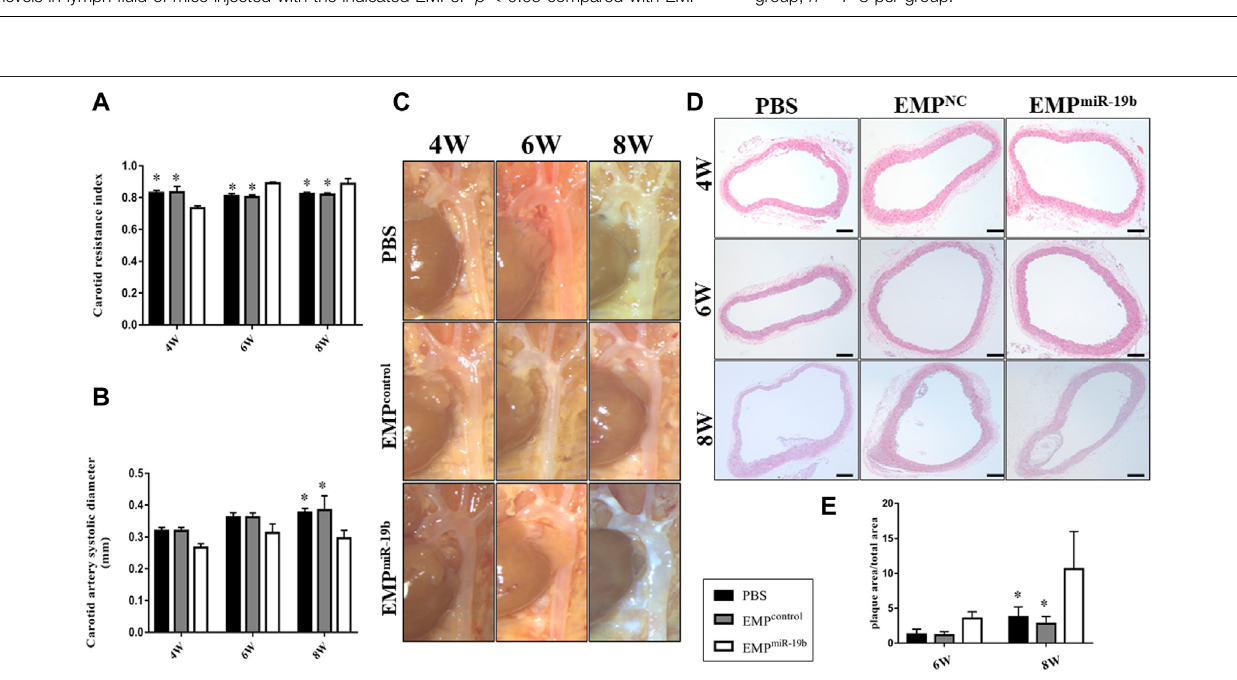
FIGURE 3 | EMP miR-19b promotes atherosclerotic plaque formation in ApoE − / − mice. (A) Carotid ultrasound was used to assess arterial fl ow velocity (V) of carotid artery. The peak systolic velocity (PSV) and end-diastolic velocity (EDV) were measured and used to calculated the resistive index (RI) = (PSV – EDV)/PSV, as a fl ow parameterre fl ectingvascularresistanceandvascularcompliance. (B) Aorticdiameterinsystolicstageasameasureofarterysize. (C) Grosspathologicalspecimenfrom high-fat diet-fed ApoE -/- mice intravenously injected with PBS, EMP control or EMP miR-19b for 4, 6, or 8 weeks. Representative images are presented. (D) Representative images of H&E staining of aortic sections from high-fat diet-fed ApoE − / − mice intravenously injected with PBS, EMP control , or EMP miR-19b for 4, 6, or 8 weeks. (E) Quantitative morphometric analysis of lesion area in (D) . * p < 0.05 compared with EMP miR-19b group, n = 7 – 8 per group.